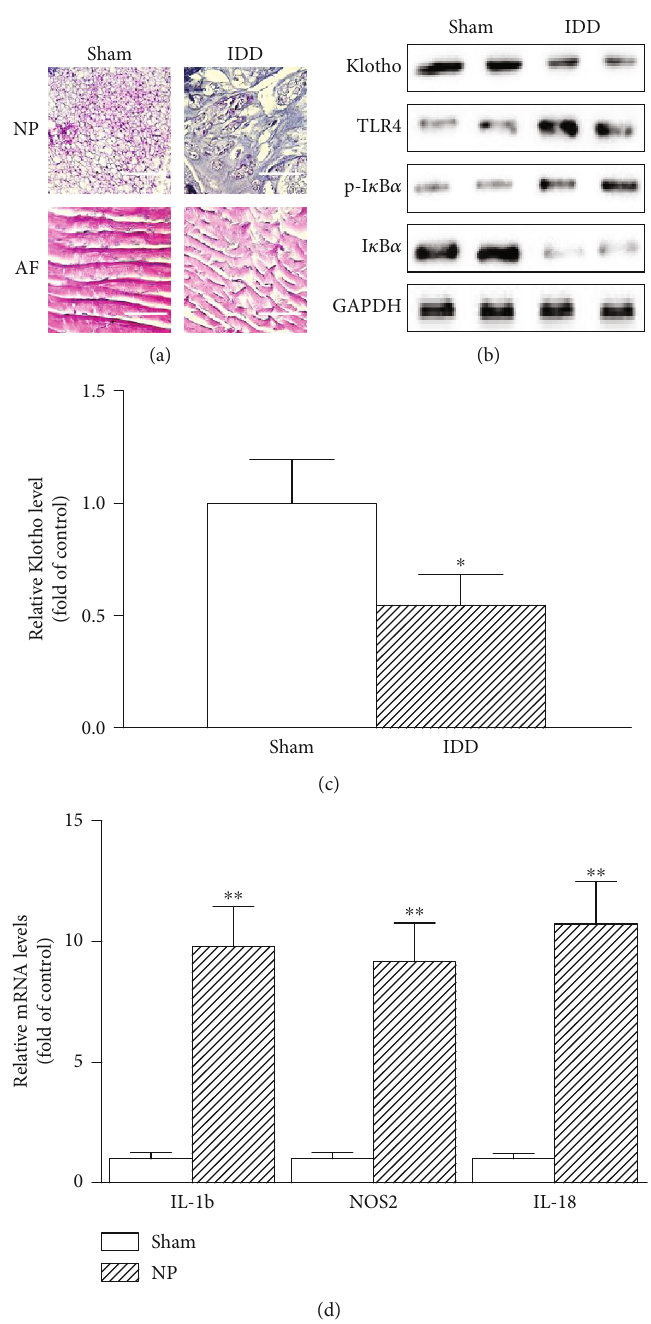
Figure 1: The expression of Klotho decreased and the activation of TLR4-NF- κ B signaling in degenerative intervertebral disc. Rats were treated with or without needle puncture (np) for 2 weeks. (a) Representative photomicrographs of H&E-stained intervertebral disc sections ( n = 6 in each group). Typical histologic appearance of the annulus fi brosus (AF) and NP from normal and degenerated discs is induced by percutaneous needle puncture. Scale bar, 20 μ m (original magni fi cation, × 40). (b) Representative protein levels of Klotho, TLR4, p-I κ B α , and I κ B α assayed by Western blotting (two randomly selected samples from each group were shown). (c) Klotho mRNA levels by qPCR. (d) Average mRNA levels of IL-1 β , NOS2, and IL-18 were assayed by qRT-PCR and quanti fi ed as fold changes ( n = 6 in each group). Data were presented as mean ± SD . ∗ P < 0 : 05 , ∗∗ P < 0 : 01 vs.